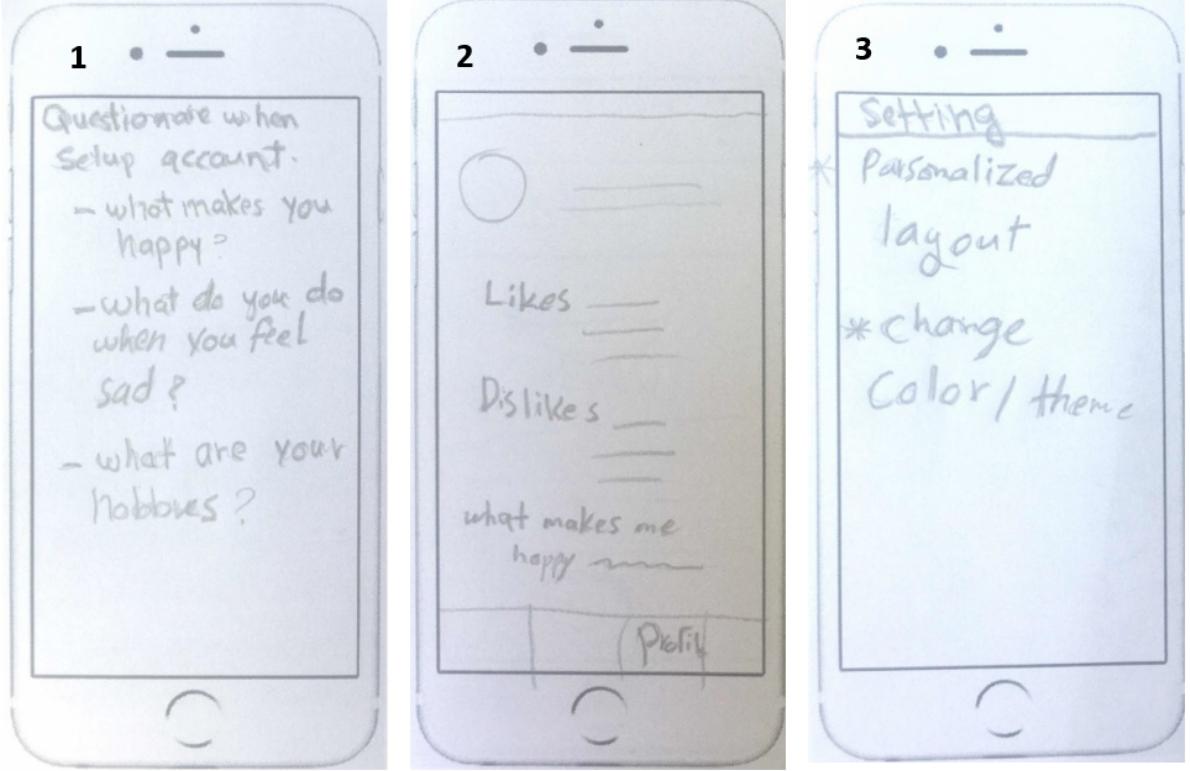
Figure 6. Three implementation ideas of a personalization feature: (1) asking a set of questions when setting up the app; (2) including a profile with users’likes, dislikes, and what makes users happy; and (3) customizing the layout and theme of the